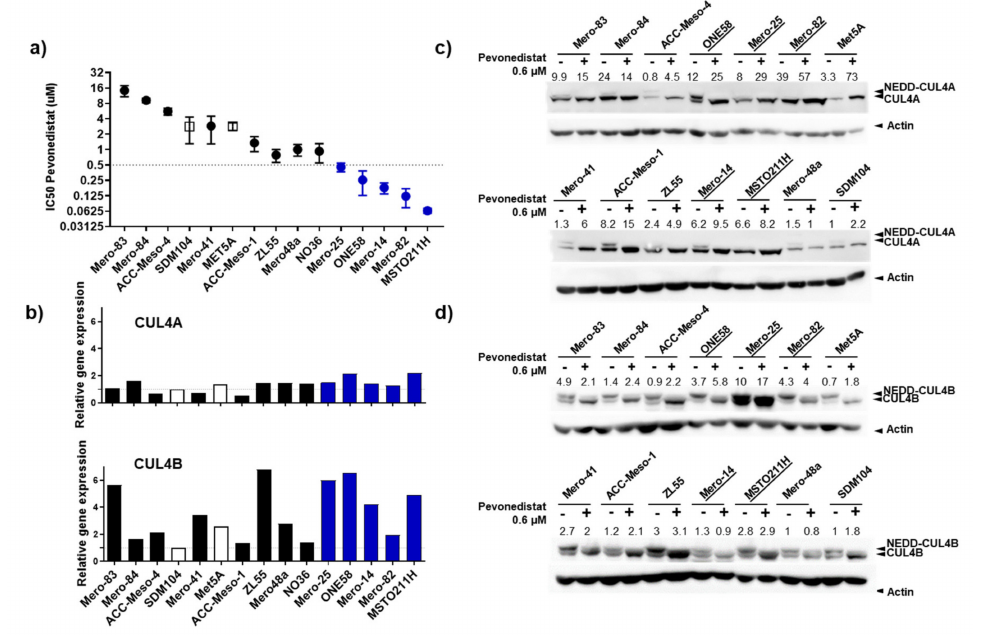
Figure 2. In vitro response of MPM cell lines to pevonedistat. ( a ) IC 50 showing the pevonedistat concentration ( µ M) required for the inhibition of 50% cell survival after 3 days of drug exposure (3-(4,5-dimethylthiazol-2-yl)2,5-diphenyltetrazoliumbromide(MTT)assay).